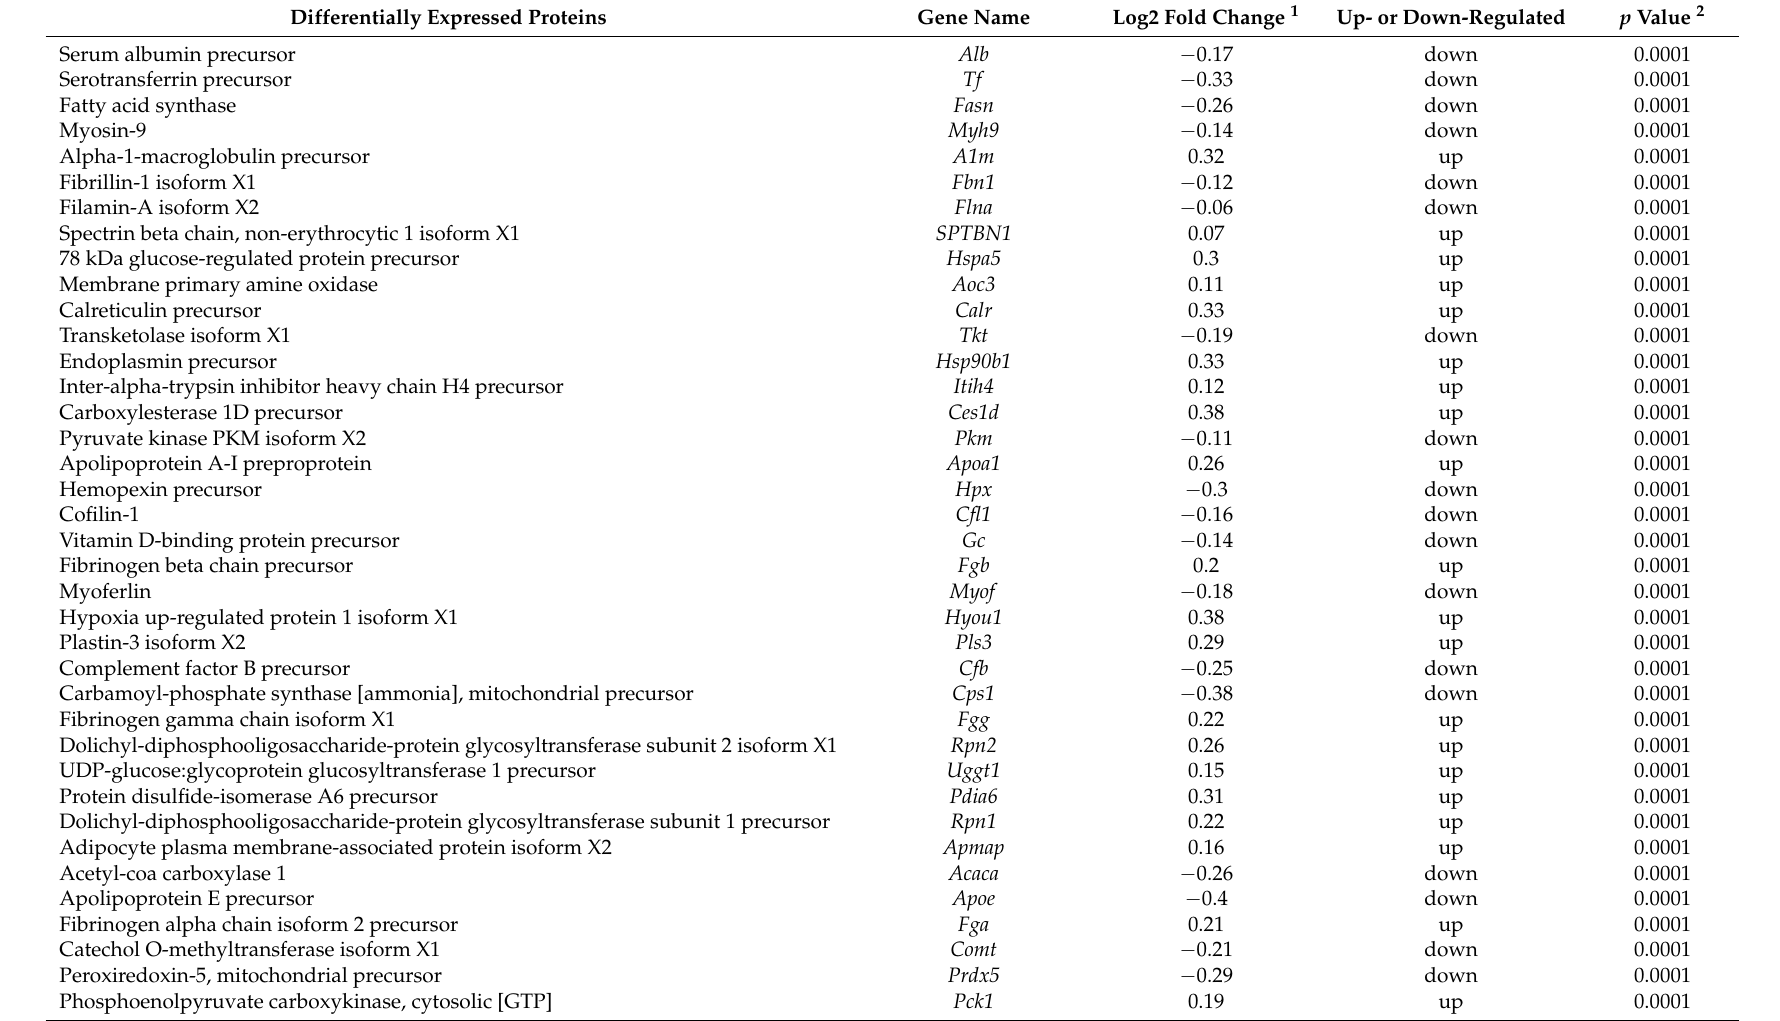
Table 2. Differentially expressed proteins with Purple Potatoes diet in adipose